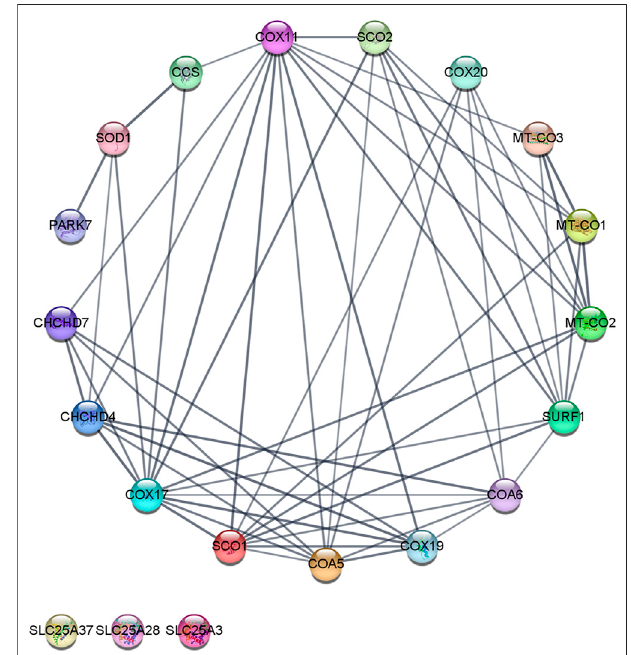
FIGURE 3 | Copper protein network in mitochondria – STRING interaction network. The interaction network was created with the STRING (Search Tool for the Retrieval of Interacting Genes/Proteins) database version 11.0. A medium con fi dence cutoff of 0, 7 was implemented in this work. The resulting protein association network for copper was visualized by a Cytoscape v3.8.2. Proteins are presented as nodes (circles) connected by lines(Edge) whose thickness represents the strength oftheconnectionbased on the STRING database. For example, in the network ’ s inferior part, three nodes ( “ SLC25A28, ” “ SLC25A37, ” and “ SLC25A37 ” ) are not connected to the network. The node “ CCS ” is connected to “ COX11, ” “ COX17, ” and “ SOD1 ” nodes. The edge (line) that connected “ CCS ” with “ SOD1 ” is thicker than the edge between “ CCS ” and “ COX11, ” and nodes (shared named, Stringdbcanonicalname,displayname,neighborhood connectivity — number of neighbors). COX17 (9606. ENSP00000261070, Q14061, COX17,